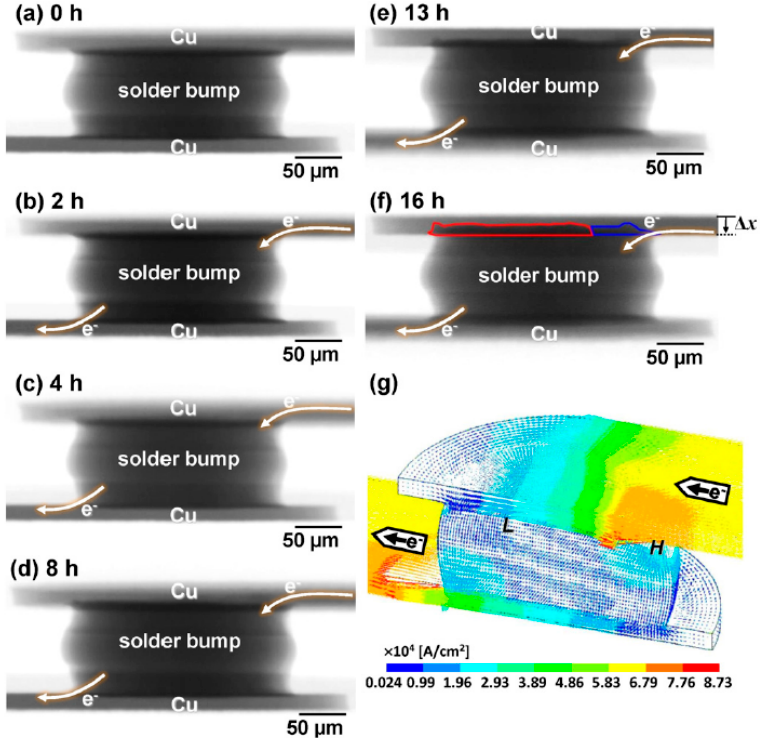
Figure 2. A series of X-ray micrographs demonstrating the interior microstructure evolution of a solder joint under 1.1 × 10 4 A/cm 2 current stressing for t = ( a ) 0 h (initial), ( b ) 2 h, ( c ) 4 h, ( d ) 8 h, ( e ) 13 h, and ( f ) 16 h. ( g ) FEA simulation of the current density Reprinted with permission from Ref. [42] Copyright 2016 Elsevier.